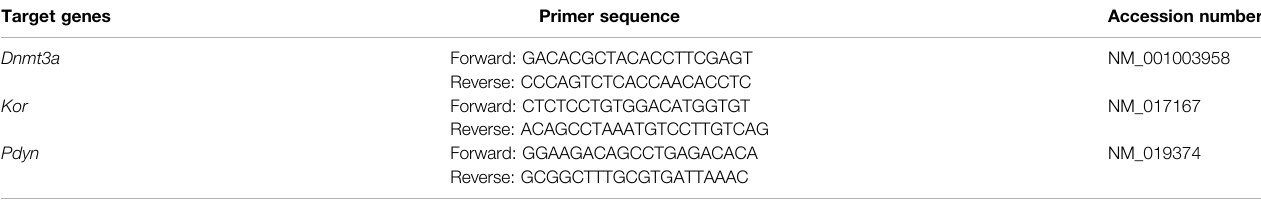
TABLE 2 | qPCR primer sequences for the gene promoter region assay.